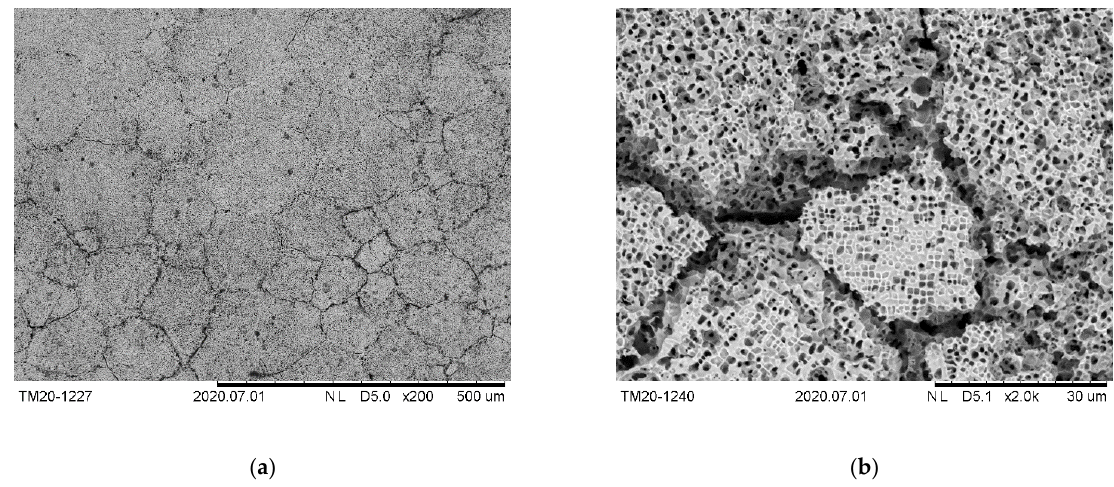
Figure 7. BSE-SEM images of the surface of a tensile specimen. ( a ) Transition area between perfect selectively etched structure and non-selective attack. ( b ) The damage occurs mainly at the grain boundaries.